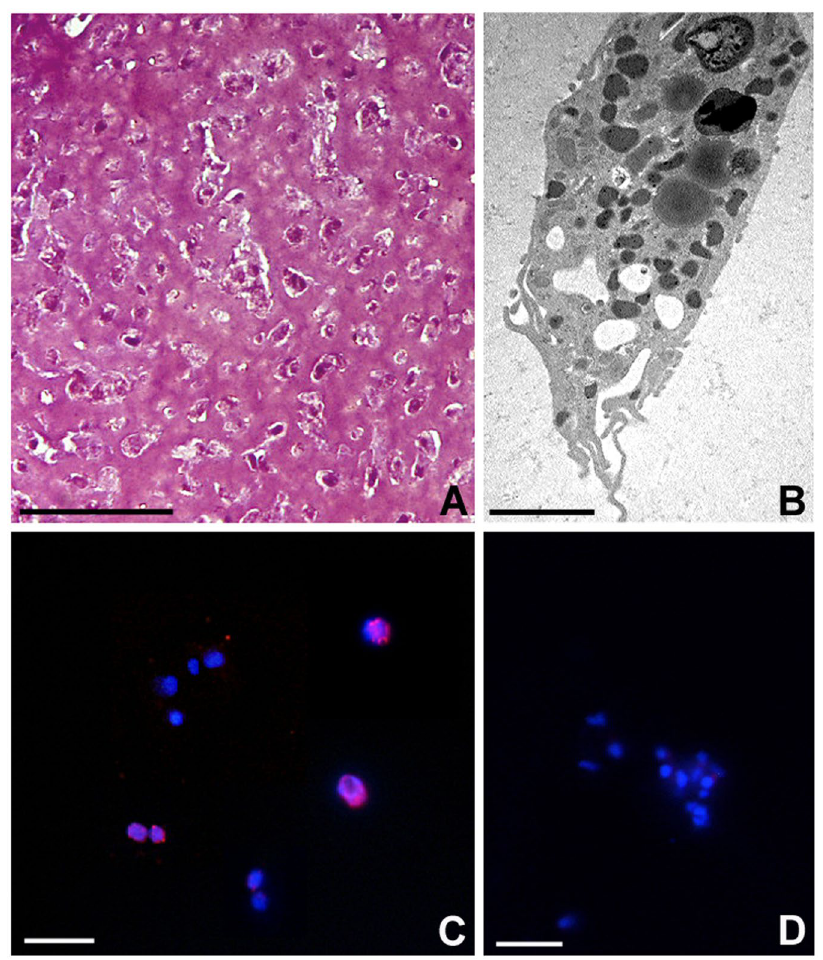
Figure 1. Phenotype analysis of cells recruited into the matrigel sponges by Hm AIF-1 ( A , B ) and proliferation assay ( C , D ). After 1 week in vivo , MG is infiltrated by numerous cells stained by crystal violet and basic fuchsine ( A ). Ultrastructural analysis at TEM ( B ) confirm the macrophagic nature of the migrating cells in the MG sponges. Immunofluorescence experiment ( C ) shows BrdU + nuclei (in red) in most of the cell migrated in the MG sponges. No signal is detected in negative control experiments ( D ) where the primary antibody was omitted. Nuclei are counterstained with DAPI (blue). Bar in ( A ) 50 µ m; bar in ( B ) 2 µ m; bars in ( C , D ) 10 µ